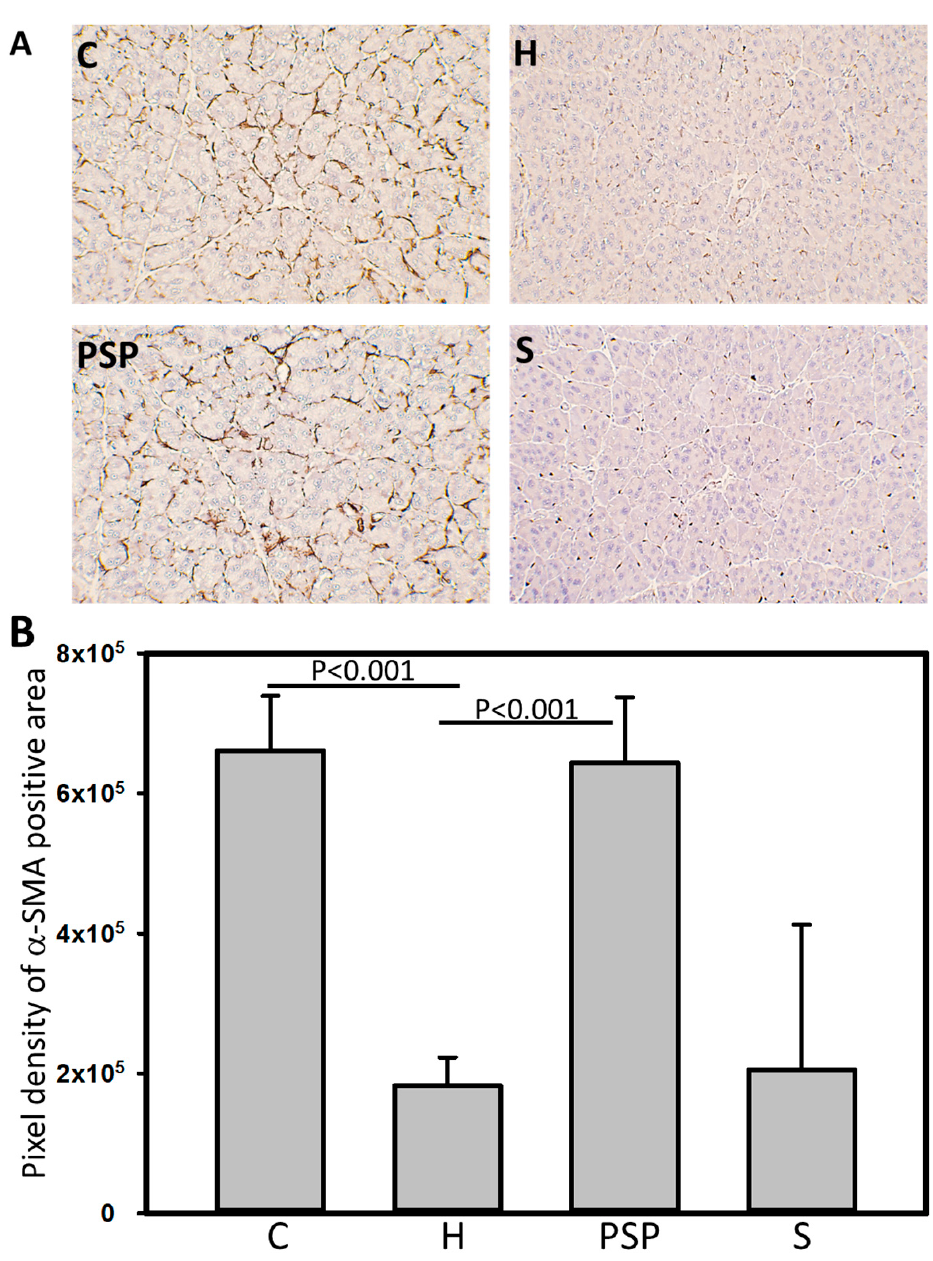
Figure 4. PSP increased α -SMA level in HFD-treated rats. Immunohistological examination was carried out to detect α -SMA level. ( A ), α -SMA-positive area were showed as brown color; ( B ), mean ± SD was represented to indicate the α -SMA-positive area. p values were denoted to show the significant differences. Aquaporin-5 (AQP5) is a water channel protein encoded by AQP5, playing a role in the generation of saliva, tears, and pulmonary secretions. To evaluate LG function, AQP5 expression was examined. Relative to that in group H, AQP5 expression was preserved in group PSP. Moreover, AQP5 expression did not differ significantly between groups H and S (Figure